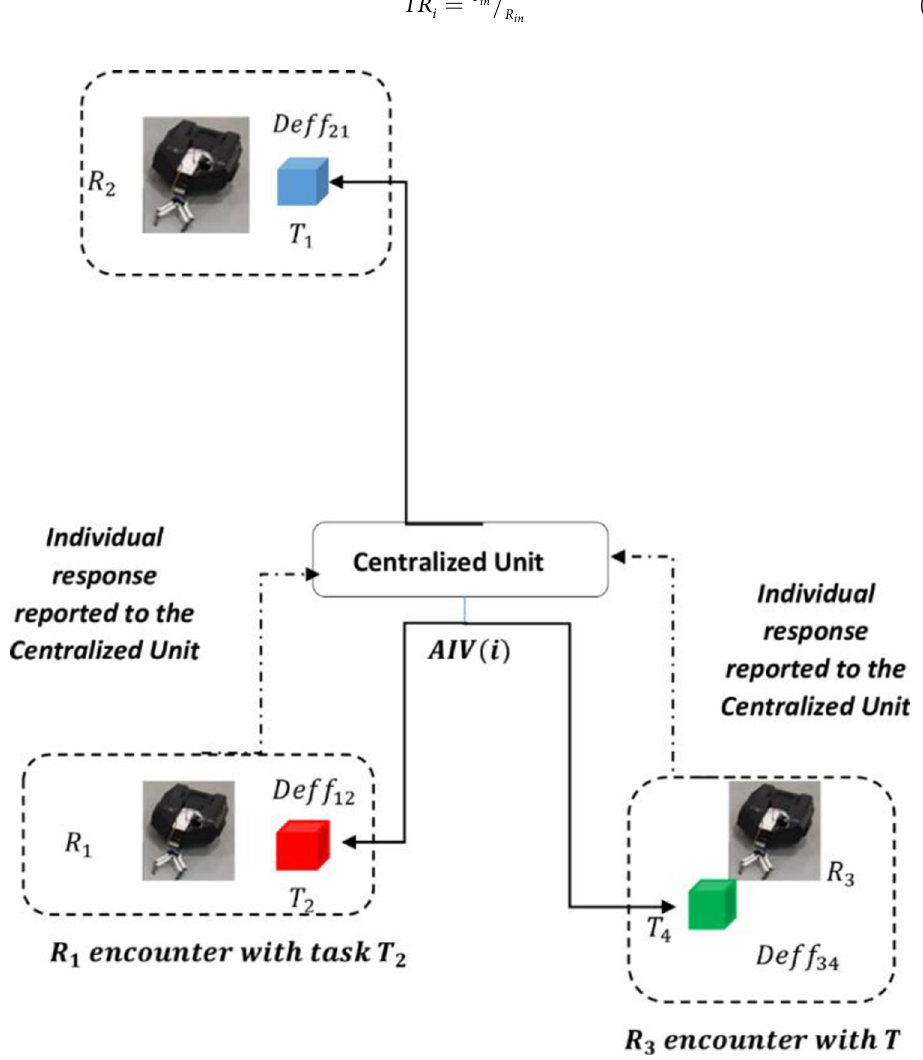
Fig 4. Generalized decentralized task-robot encounter and system status aggregation